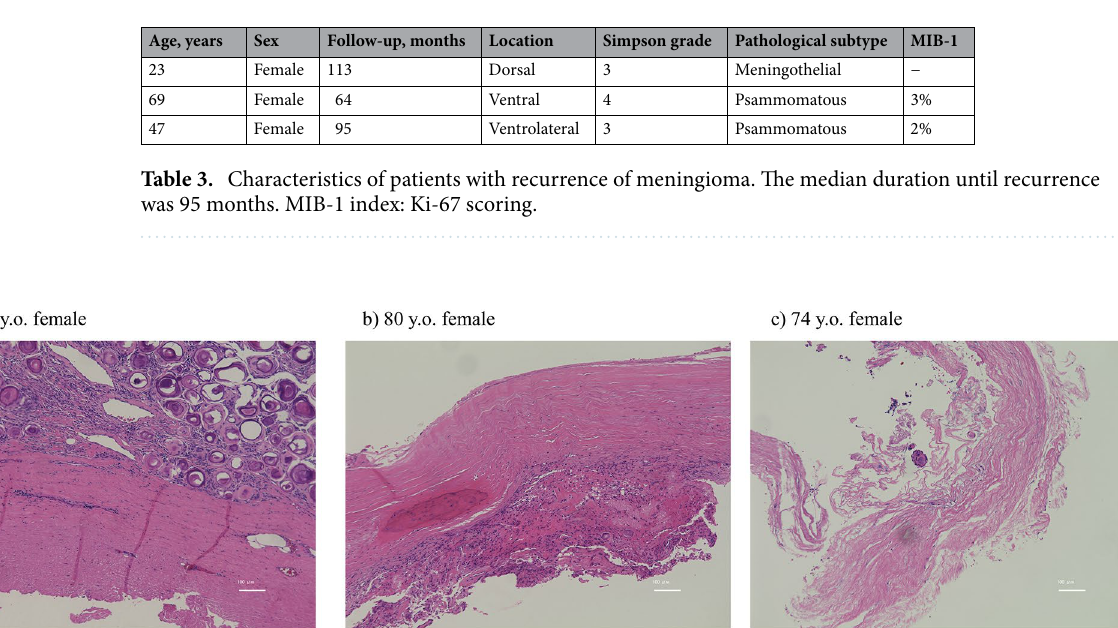
Figure 2. Pathology. Photomicrograph of resected tumor stained with hematoxylin and eosin. ( a ) Forty-four- year-old woman; psammomatous type. ( b ) Eighty-year-old woman; meningothelial type. ( c ) Seventy-four-year- old woman; meningothelial type. We removed the tumor with the inner layer of dura as a single mass in Case a and removed the adhesed inner layer of dura after tumor resection in Cases b and c. No infiltration of tumor cells in the dura mater was seen in Case a or b, but tumor infiltration was confirmed in Case